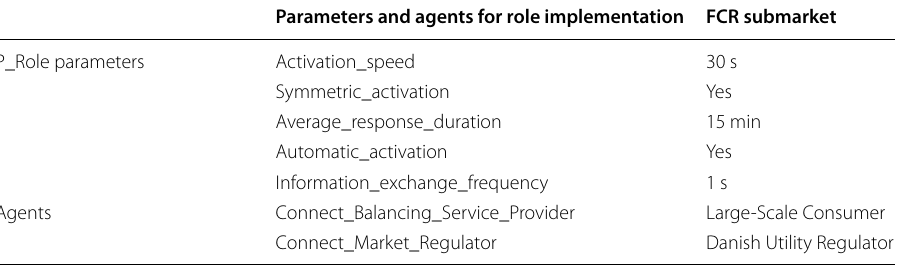
Table 6 Reserve activation role implementation for FCR submarket (data from Fatras et al. 2022b; Energinet